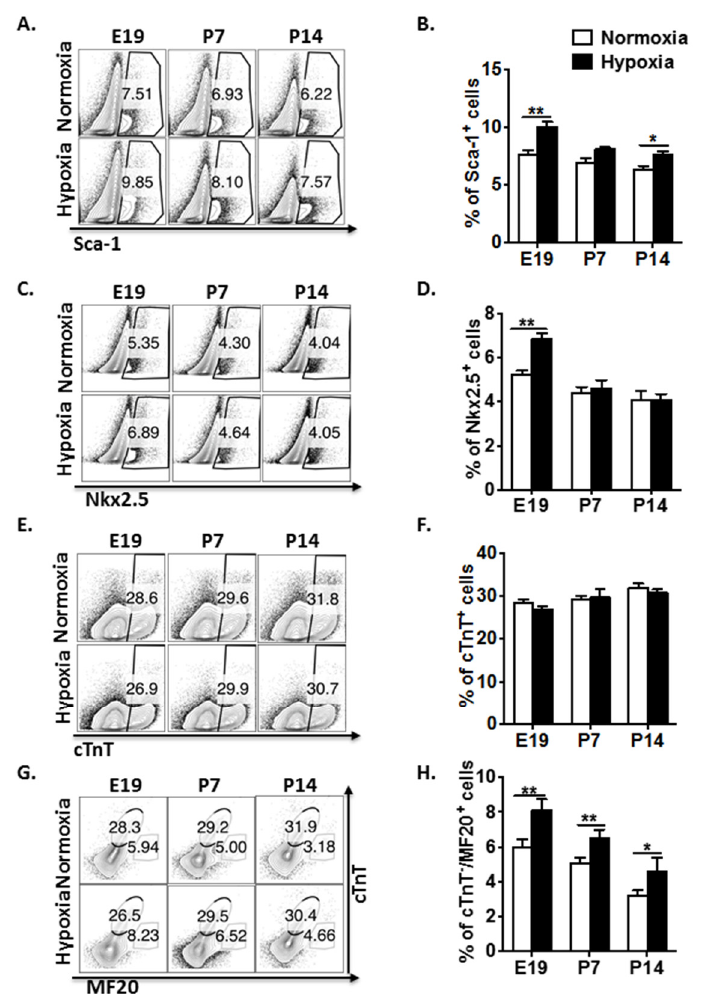
Figure 1. Hypoxia regulates cardiac progenitor cell (CPC) proliferation and restrains cardiomyocyte maturation in mouse fetal and postnatal hearts. ( A ) Representative flow plots showing the surface Sca-1 staining of cardiac cells after depletion of cardiomyocytes. ( B ) Quantification of the flow plots